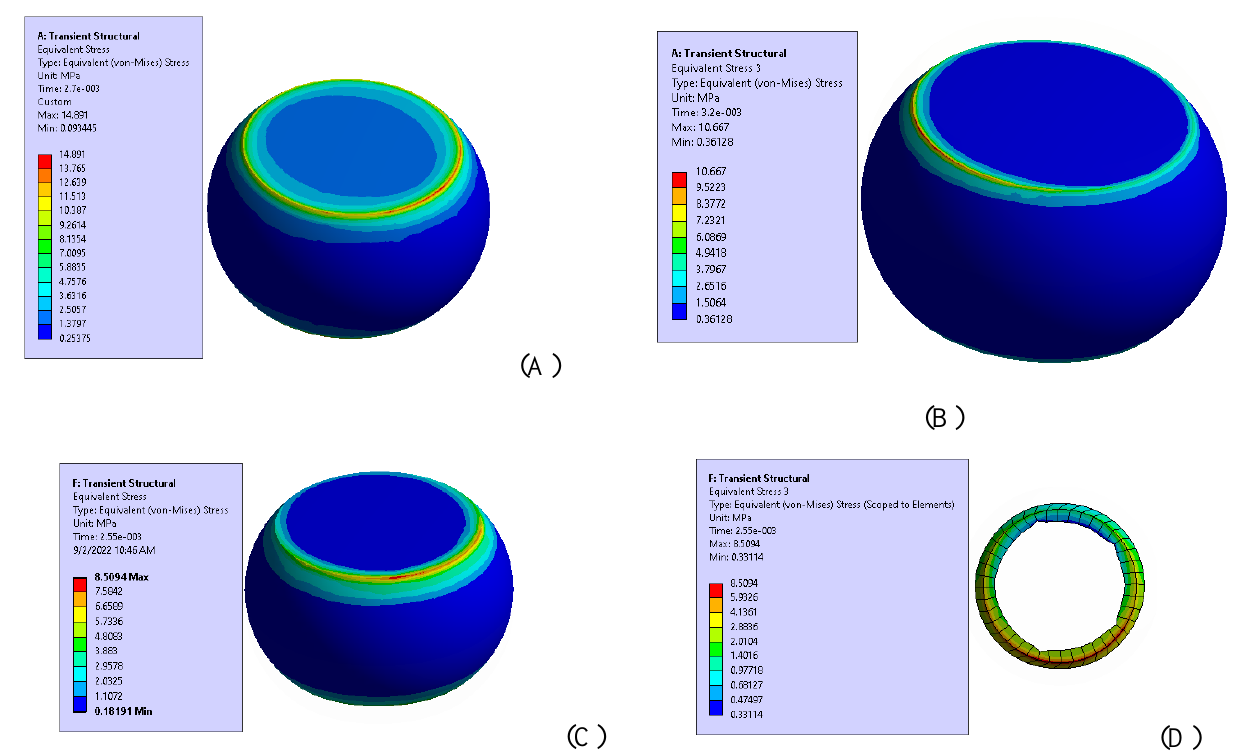
Figure 11. Maximum steady state stress amplitude at the solder ball (sample 1).